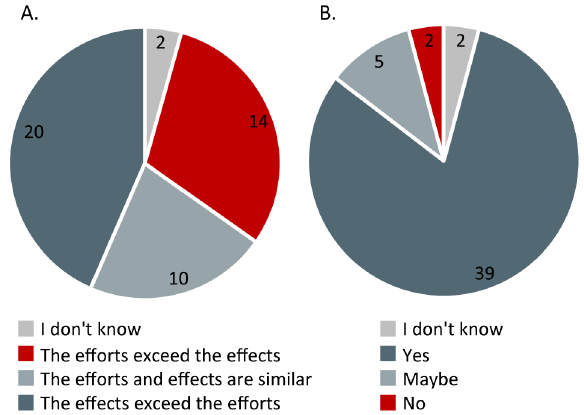
Figure 6. The balance between the efforts versus effects of the low carbohydrate ketogenic diet on overall functioning ( A ) and the tendency to recommend the low carbohydrate ketogenic diet to other individuals with McArdle disease ( B ). Based on n = 48 responses.